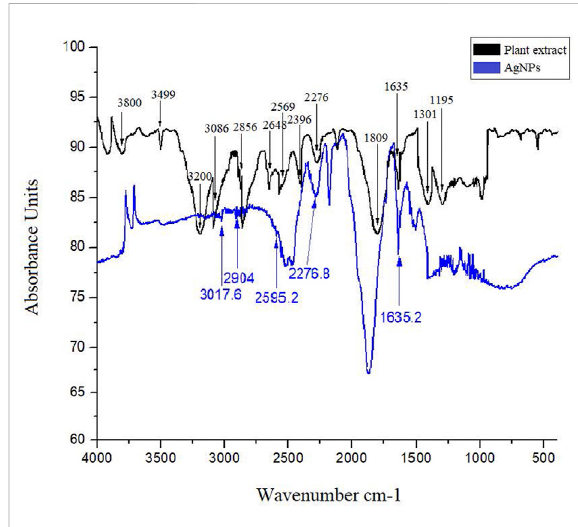
FIGURE 4 FTIR spectrum of plant extract and AgNPs showing bands for various functional groups responsible for stabilization of silver